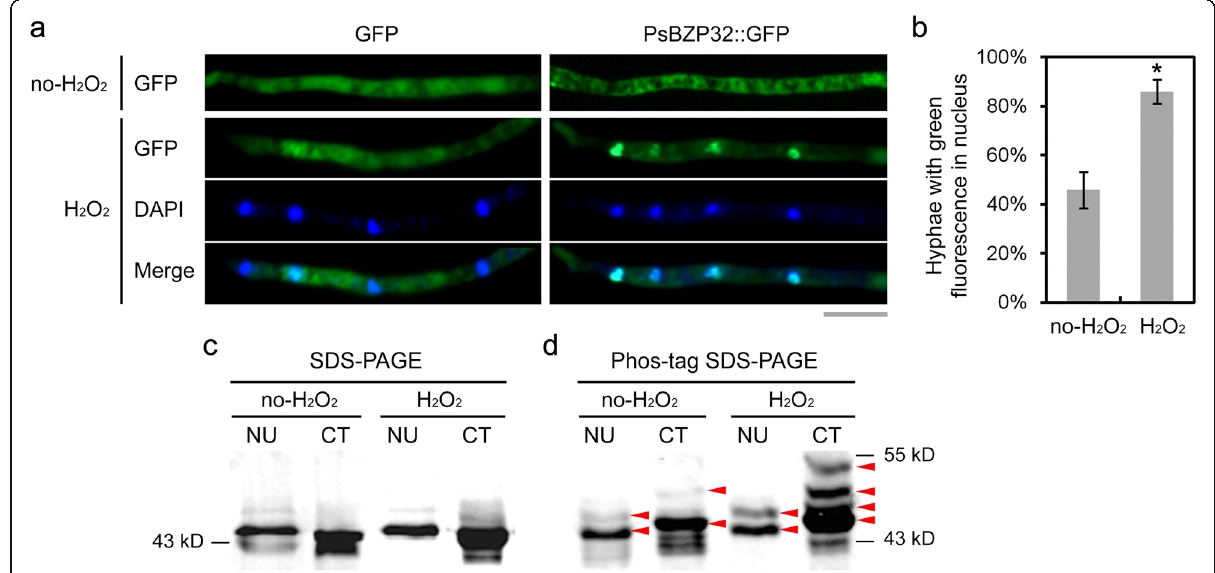
Fig. 5 Subcellular localization and phosphorylation status of PsBZP32 are regulated by oxidative stress. a Localization of PsBZP32::GFP under the native promoter of PsBZP32 . “ H 2 O 2 ” indicates that the mycelium was treated with 5 mM H 2 O 2 for 10 min. Nuclei were stained with DAPI for 5 min. Bar, 20 μ m. b Statistical analysis of the results in ( a ) using the two-tailed t -test (*, P < 0.01). c and d Cytoplasmic and nuclear proteins extracted from mycelia treated with or without 5 mM H 2 O 2 for 5 min were subjected to SDS-PAGE without ( c ) or with Phos-tag ( d ). A polyclonal antibody against prokaryotically expressed PsBZP32 was used to detect the level of phosphorylated PsBZP32 in western blot assay. CT, cytoplasmic protein; NU, nuclear protein. Red arrows indicate the bands representing phosphorylated